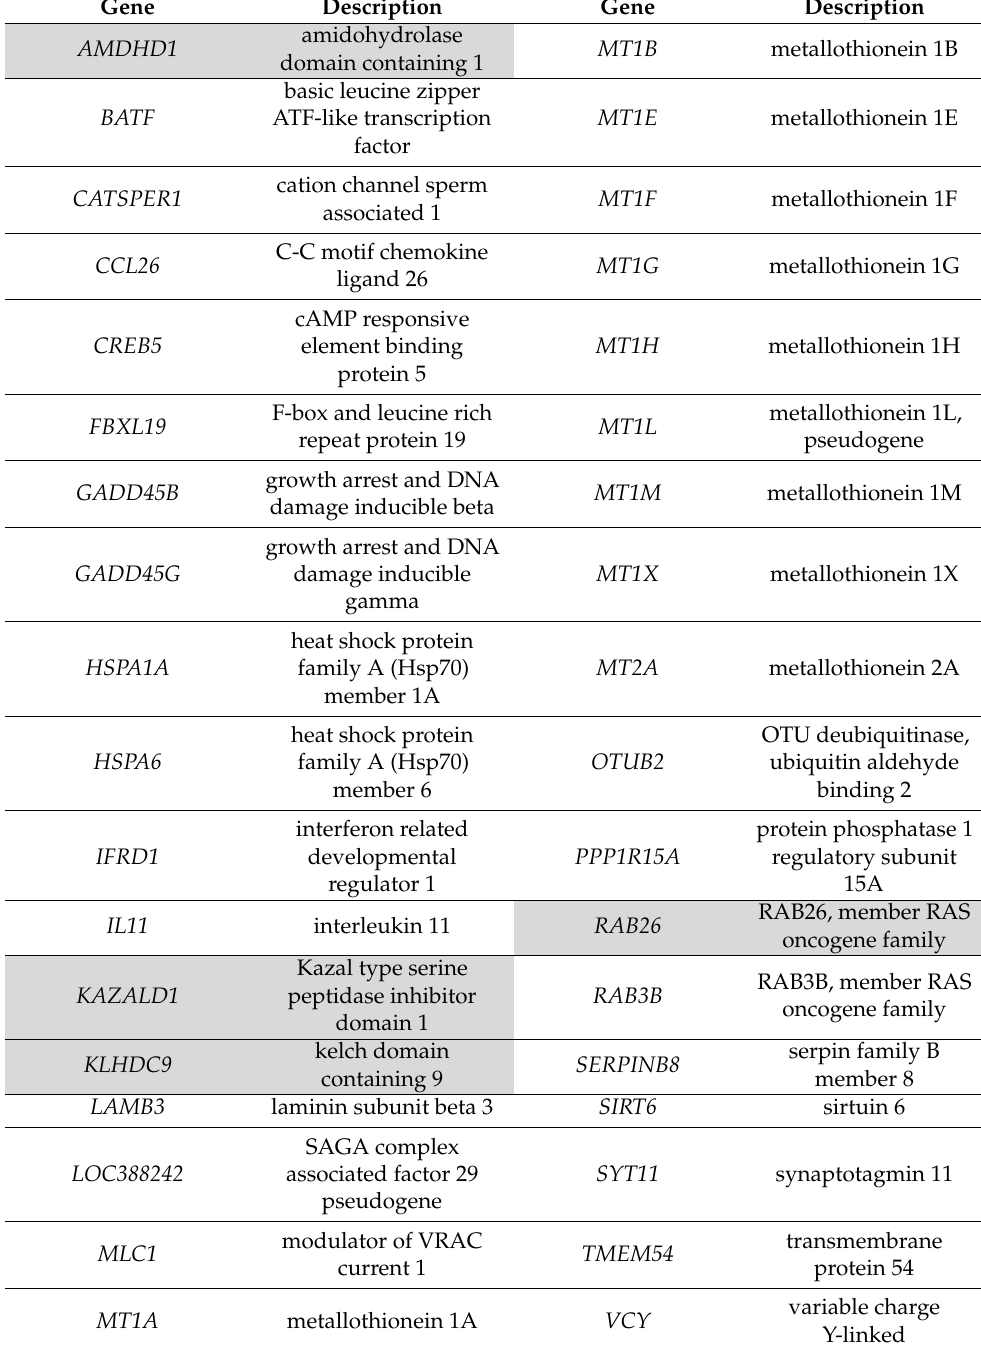
Table 1. List of deregulated genes in common in HepG2, A549 and SH-SY5Y